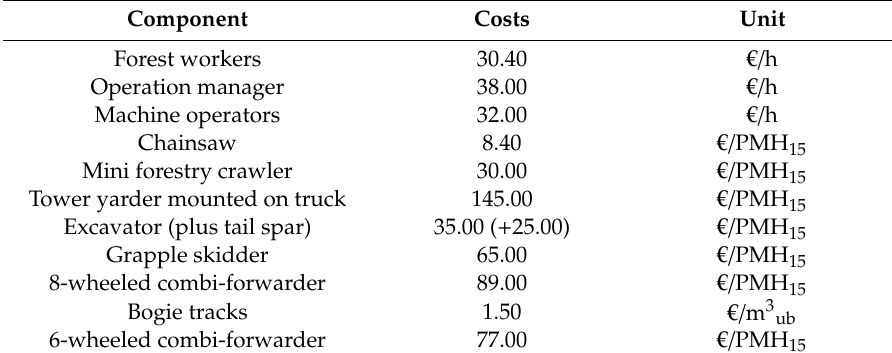
Table 2. Standard cost rates of used machines (in Euros); wages include non-wage